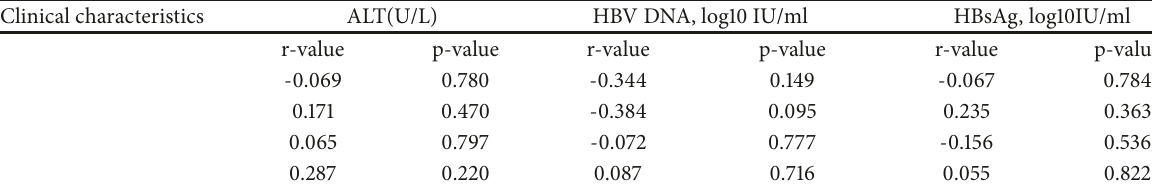
Table 4: Correlations between frequency of CCR 7 hi PD- 1 lo CXCR5 + CD4 + T cells and clinical characteristics in 4 subgroups of patients with chronic HBV infection.